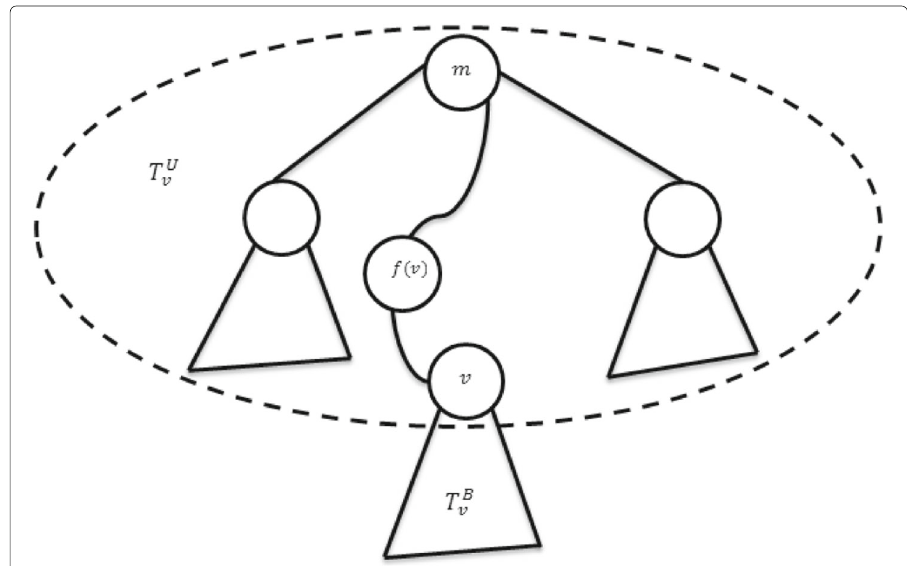
Fig. 4 Interpretation of the subtrees T B v and T U v of T